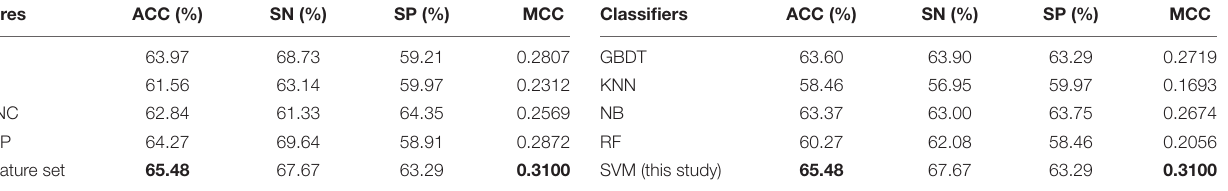
The bold value indicates the highest value of this